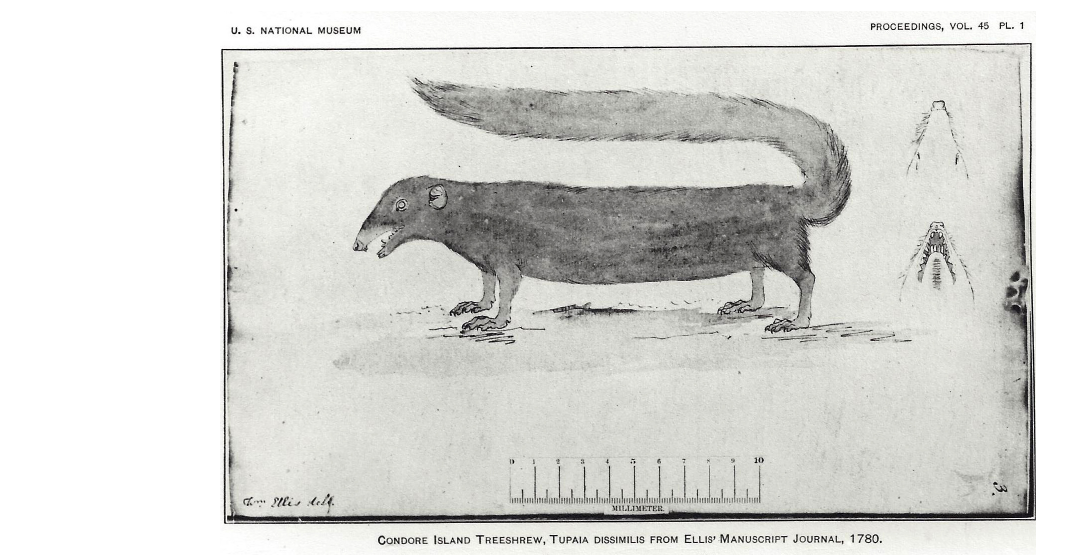
Figure 1. Tupaia dissimilis , Pulo Condore. Reproduction of the original Figure of William Ellis’ Sciurus dissimilis , in his natural history journal, written during Captain Cook’s third voyage, 1776–1780; now in the British Museum (Natural History). A scale of 100mm was laid on the page when the photograph was made. Picture taken from Lyon Jr.